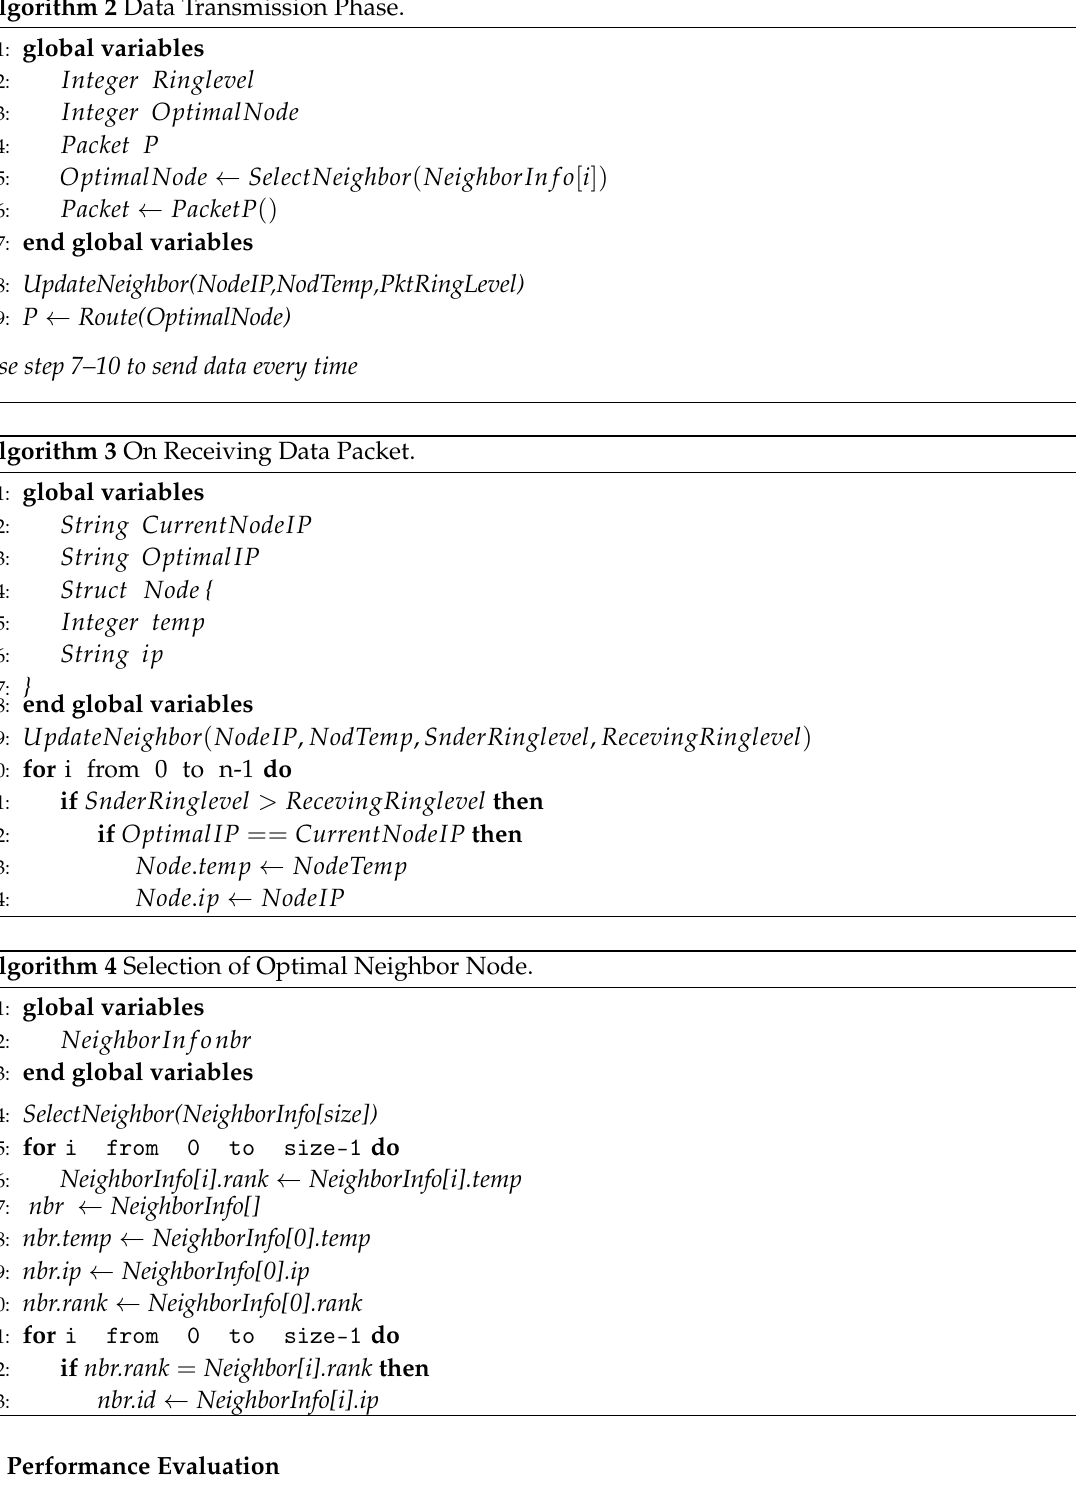
Algorithm 2 Data Transmission Phase.